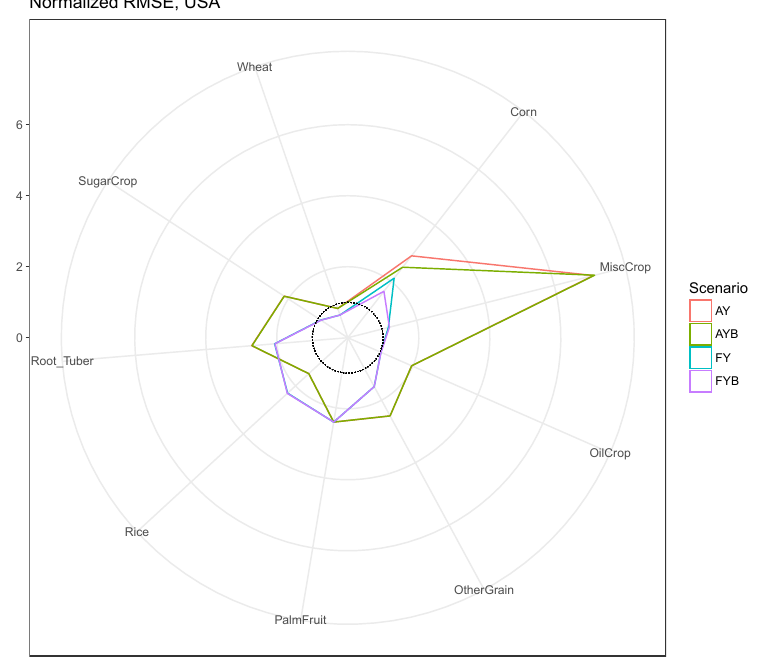
= 1; e (cid:48) compares RMSE error ij ij